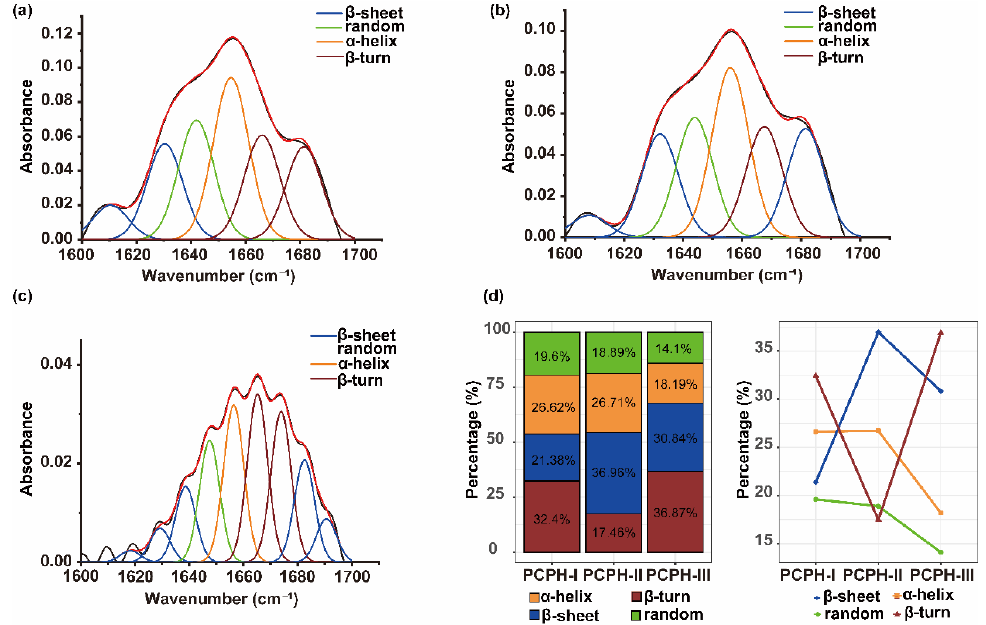
Figure 2. FTIR spectroscopy of ultrafiltration components: ( a ) Deconvolved and curve-fitted bands of the FTIR spectra of amide I of PCPH-I. ( b ) Deconvolved and curve-fitted bands of the FTIR spectra of amide I of PCPH-II. ( c ) Deconvolved and curve-fitted bands of the FTIR spectra of amide I of PCPH-III. ( d ) The secondary composition and their variation trends of PCPHs.